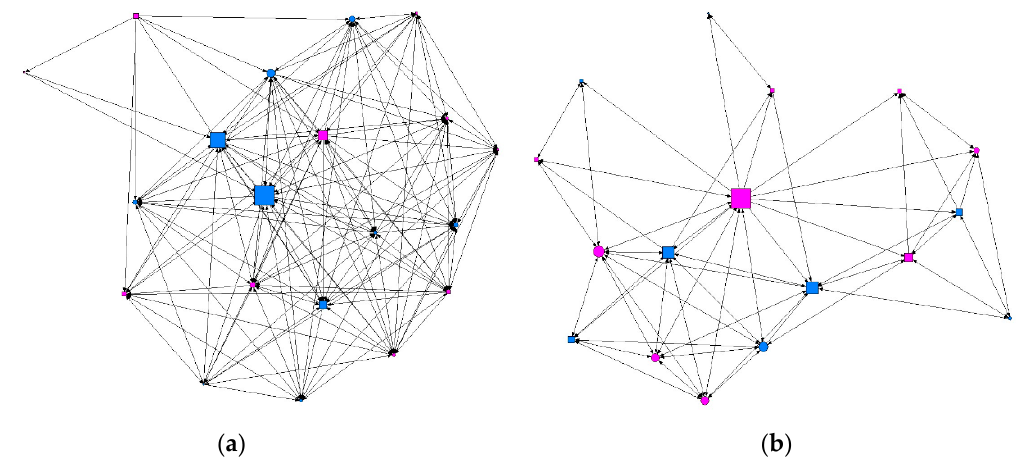
Figure 1. Graph of minimum contact intensity in a class. Males are shown in blue and females in pink; circles represent individuals whose consumption did not present a risk and squares represent individuals showing at-risk use. Graphs produced using UCINET software [48]: ( a ) where the size of the nodes indicates the degree of intermediation (betweenness); ( b ) where the size of the nodes indicates the degree of ties (degree).